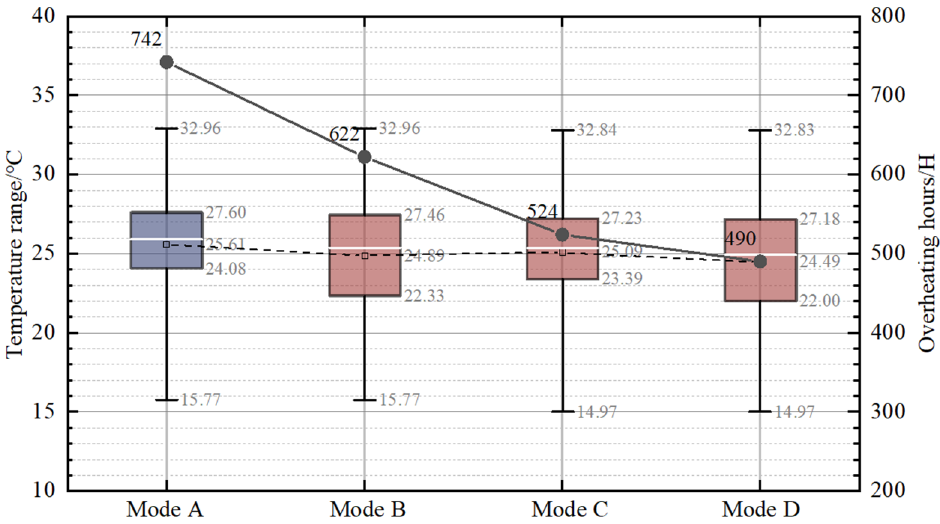
Figure 12. Influence of adjusting ventilation on indoor temperature of south facing bedroom